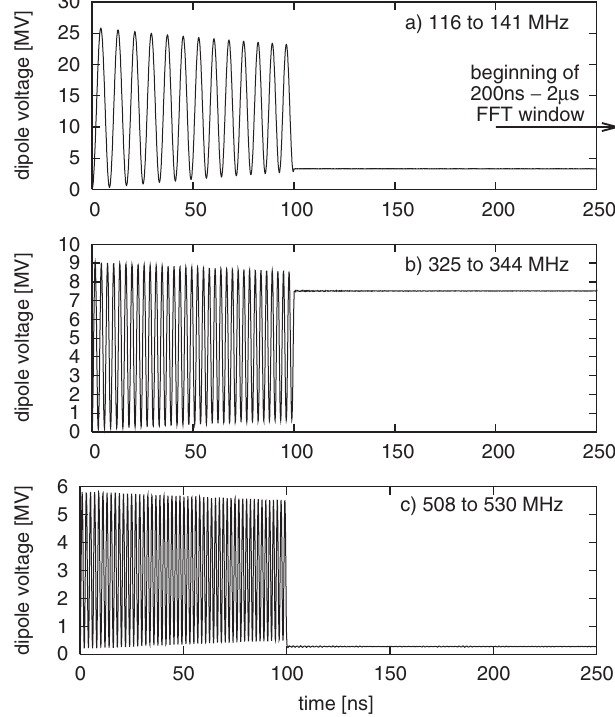
FIG. 6. Voltages of the applied dipoles used to calculate the resonance mode qualities. Plot (a) represents the frequency ramp from 116 to 141 MHz over 100 ns. Plots (b) and (c) are the frequency ramps from 325 to 344 MHz and 508 to 530 MHz, respectively. The arrow marks the beginning of the period over which the resonance qualities are calculated. The plots do not cover the full 2 (cid:1) s of the simulation time.